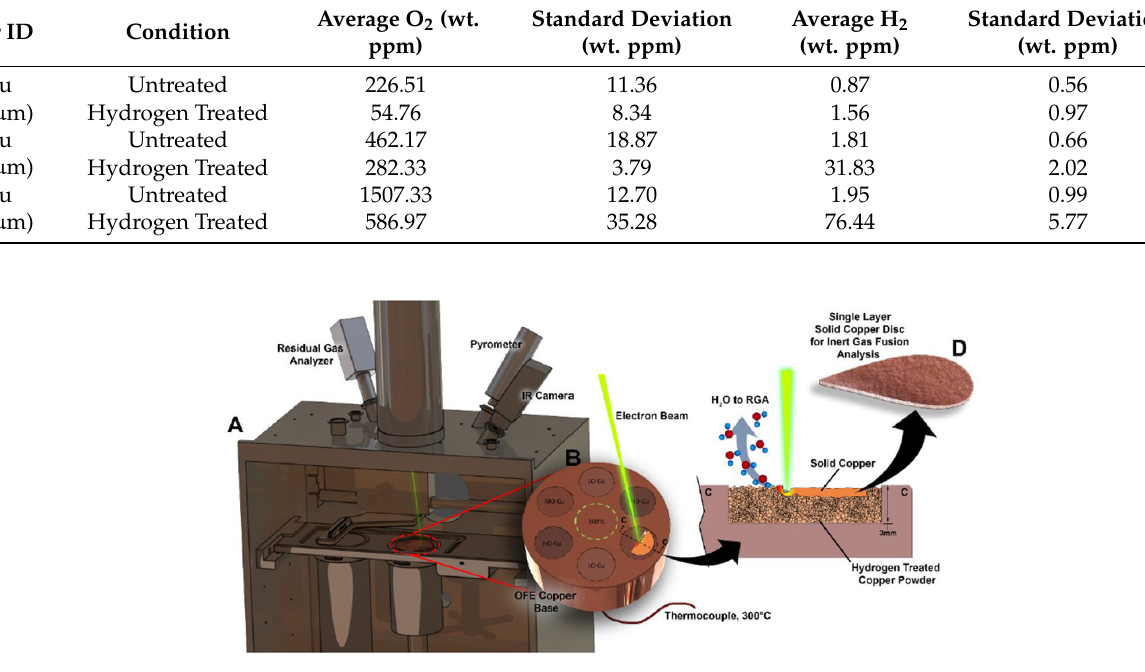
Figure 17. Sample micrographs indicating density improvement upon HIP, ( a ) Sintered Part, 1.88% porosity, ( b ) HIPed Part, 0.13%porosity calculated from image analysis. Adapted from [106] Elsevier, 2017.